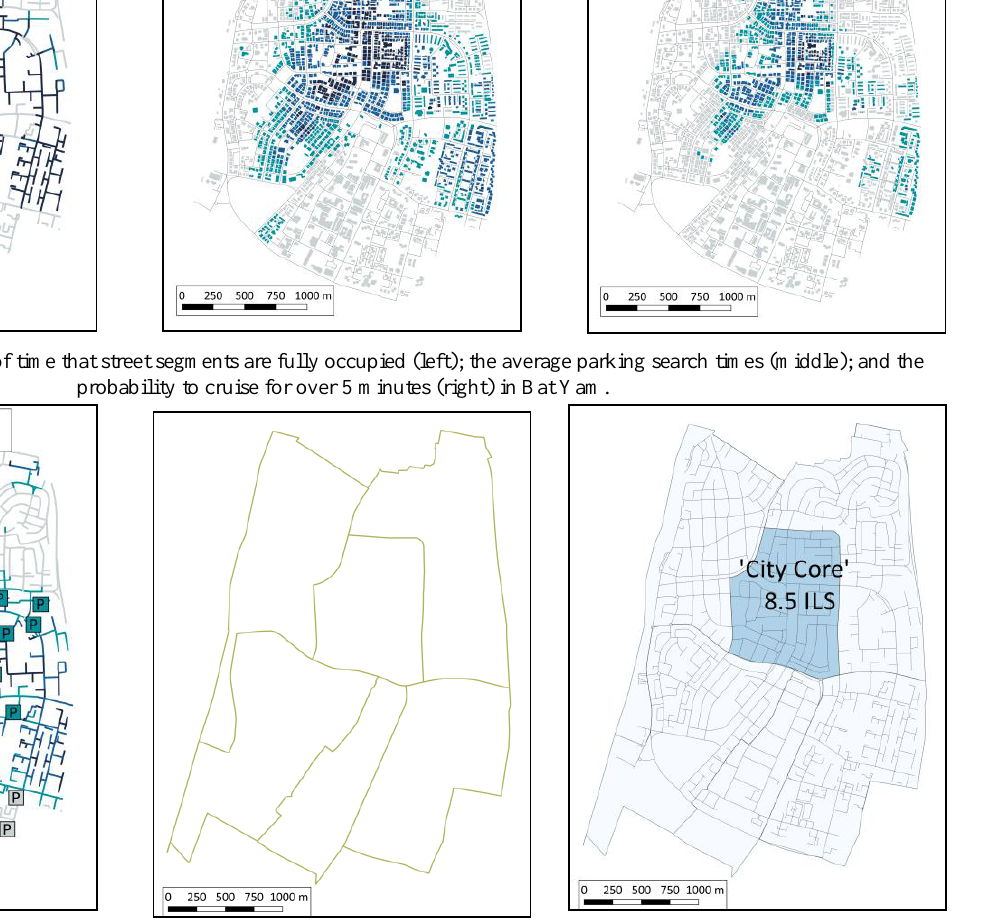
Figure 7. Equilibrium parking prices, for Figure 8. Six quarters of Bat Yam (left); and equilibrium parking prices, in ILS, for 85% occupation threshold established by 85% occupation threshold estimated by city quarters as pricing units street links and parking lots as pricing units